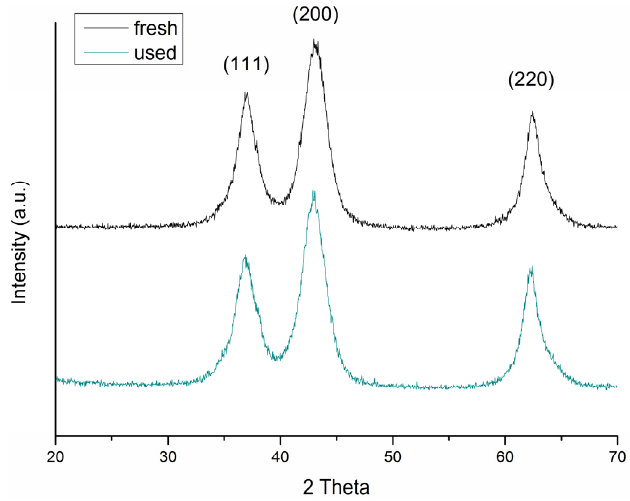
Figure 1. XRD of the fresh and used Au SI /NiO catalyst after six cycles. Table 1. Statistical median and standard deviation of Au particles size.